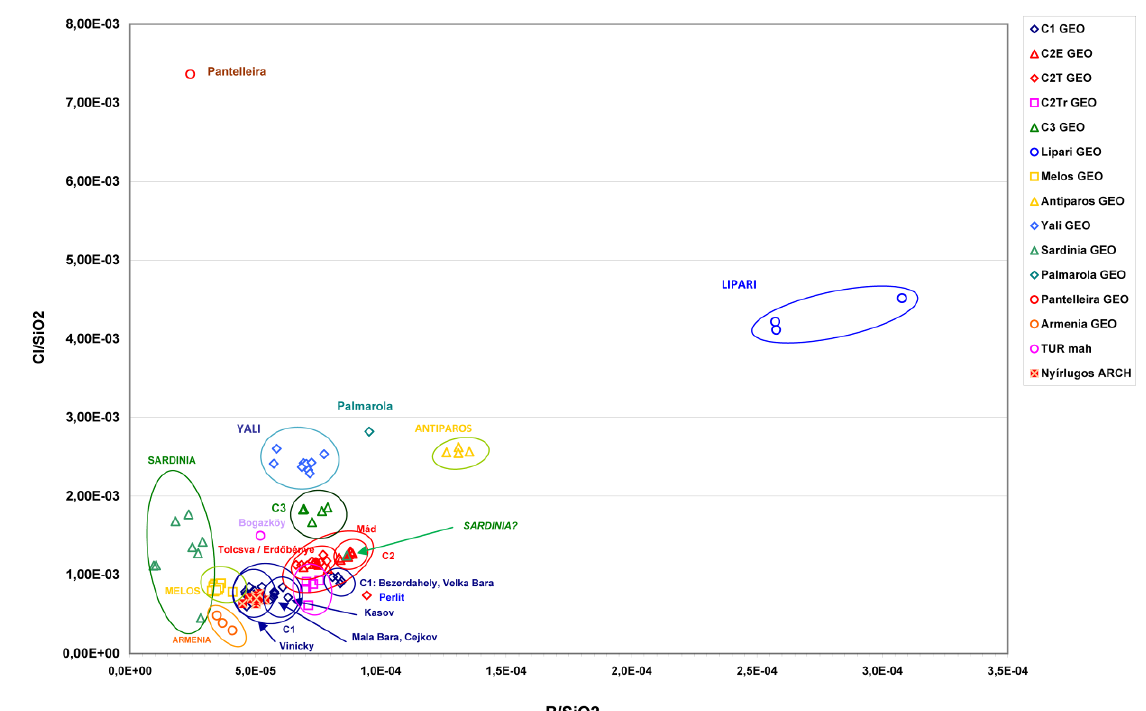
Figure 5. Separation of obsidian source regions on the basis of B/SiO hoard is compared with geological reference samples.